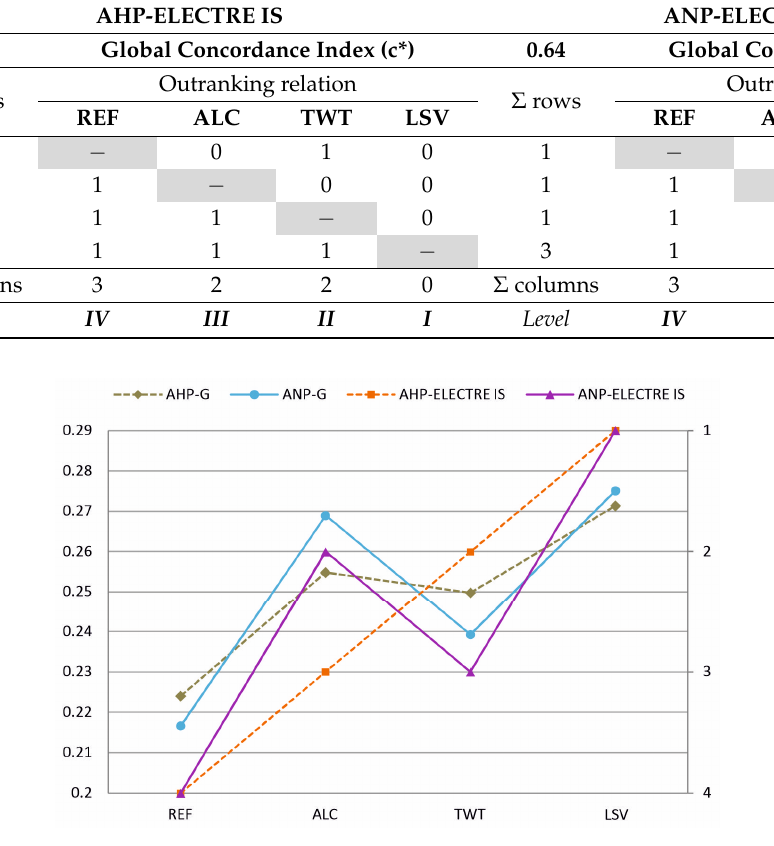
Figure 4. Ranking of alternatives for each MCDM technique.